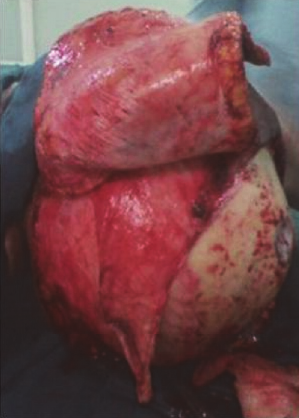
Figure 2: Scalp axial flap raised based on the supraorbital and supratrochlear vessel.